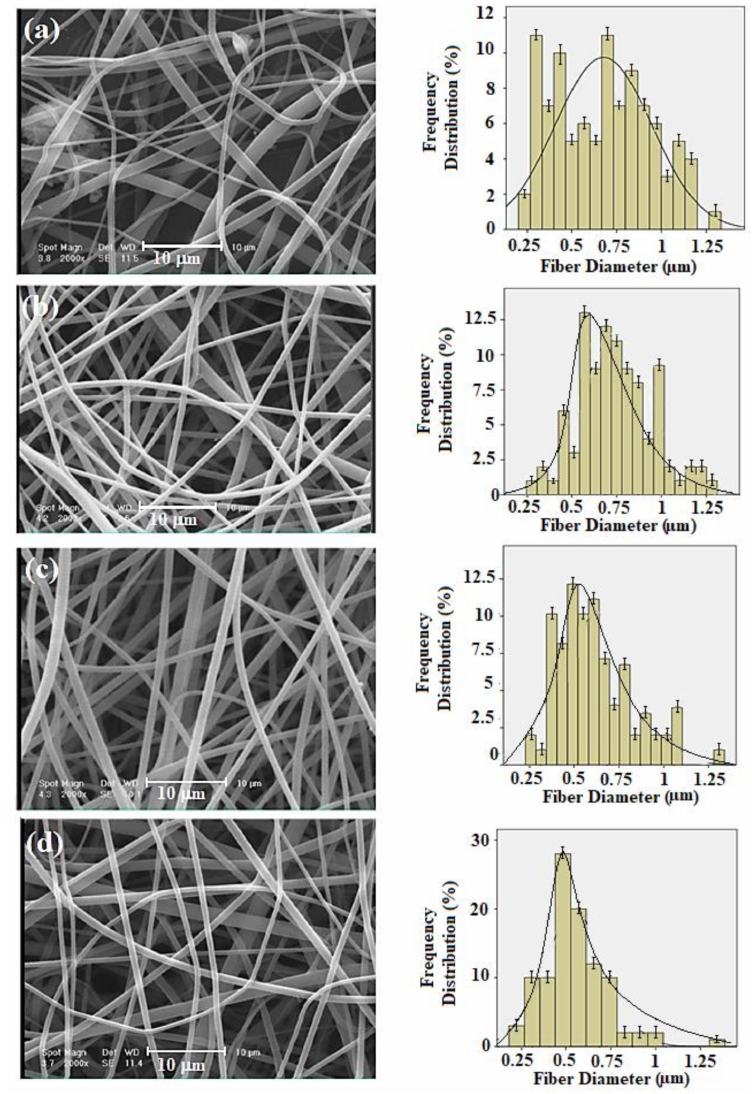
Figure 3. SEM images and frequency distribution of the fiber diameter for ( a ) PVPA–ESM,